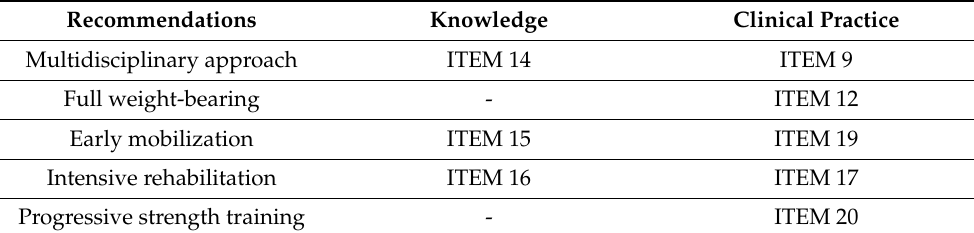
Table 2. Knowledge and clinical practice items of evidence-based